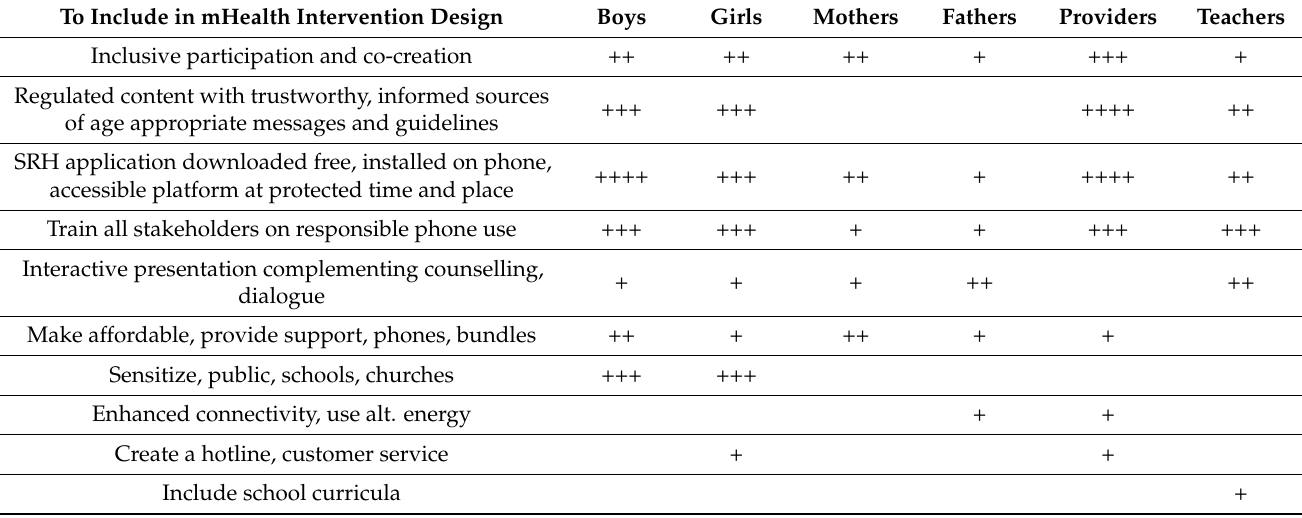
Table 3. Recommendations in mHealth design by respondent